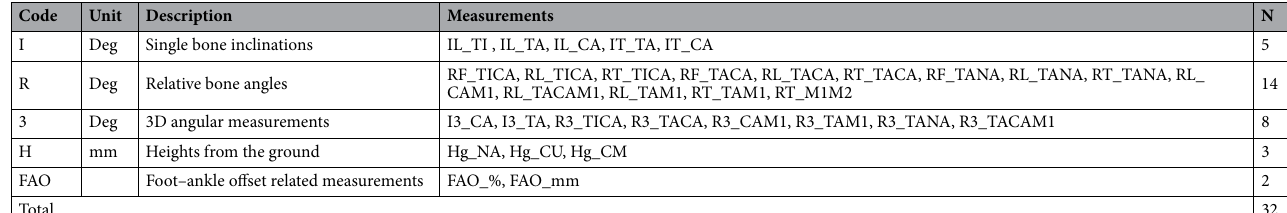
Table 1. List of the 32 original measures, with Units, Descriptions and relevant Acronyms.